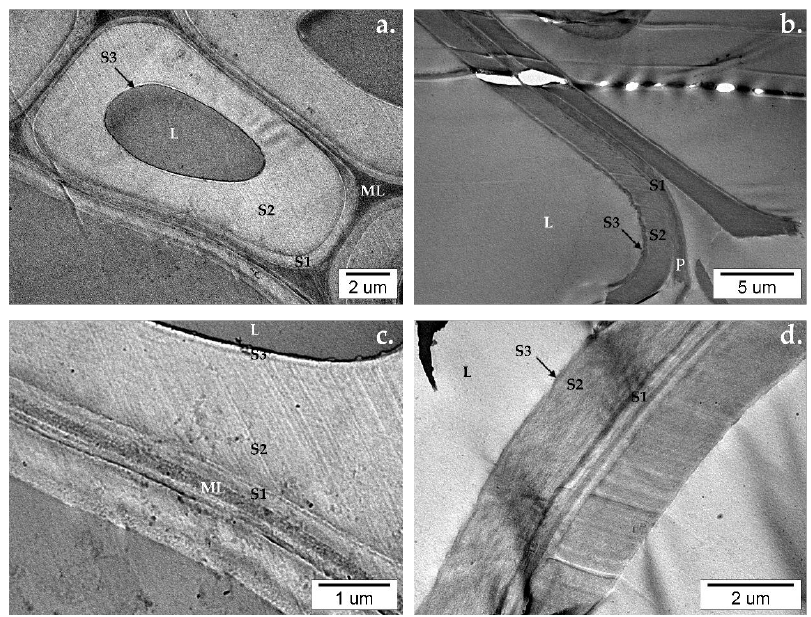
Nanomaterials 2022 , 12 , x FOR PEER REVIEW Figure 15. TEM micrographs of ( a , c ) native beech and ( b , d ) pine wood ’ s cell wall ultrastructure. Figure 15. TEM micrographs of ( a , c ) native beech and ( b , d ) pine wood’s cell wall ultrastructure. Micrographs from samples irradiated with UV light and uncoated with TiO 2 show significant changes occurring especially in the middle layer of the secondary wall (S2). Both in beech and pine wood, numerous fissures appear, mostly perpendicular to the S1 layer. The fissures start in the area of the S3 layer. Small perforations forming fissures are visible in the S2 layer of the beech (Figure 16e) and pine wood cells (Figure 16d,f).